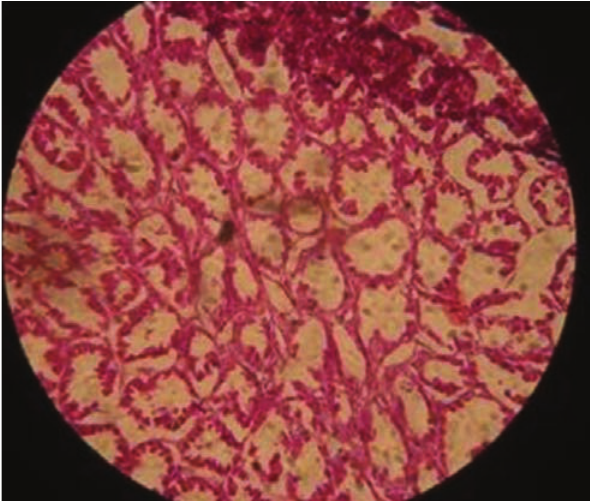
Figure 3: Stunted chick showing bursal lymphocytes depletion.